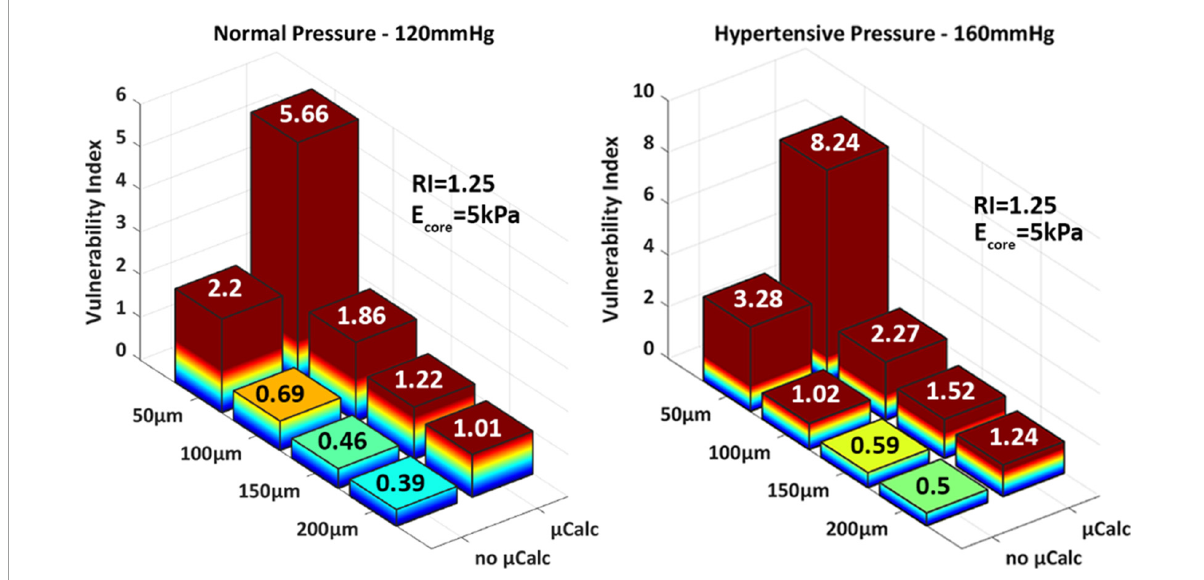
FIGURE6 3D-barplots of the change of the vulnerability index based on cap thickness, the presence of a spherical µ Calcs at the center of the cap and blood